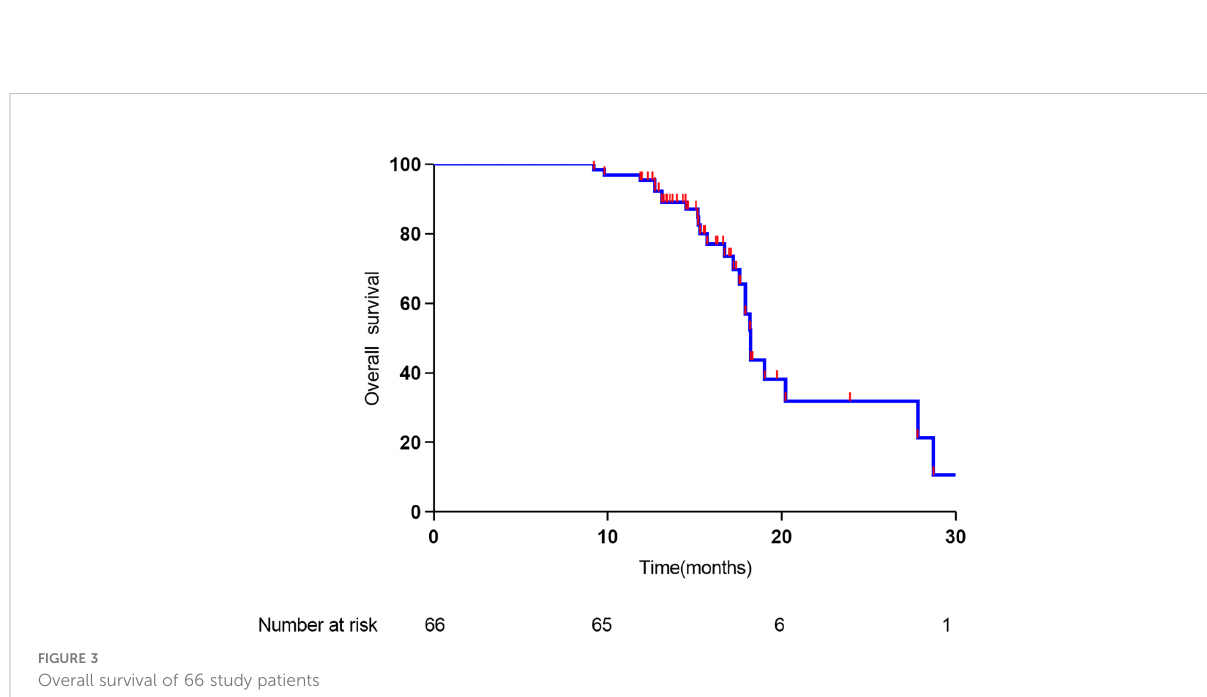
FIGURE 3 Overall survival of 66 study patients